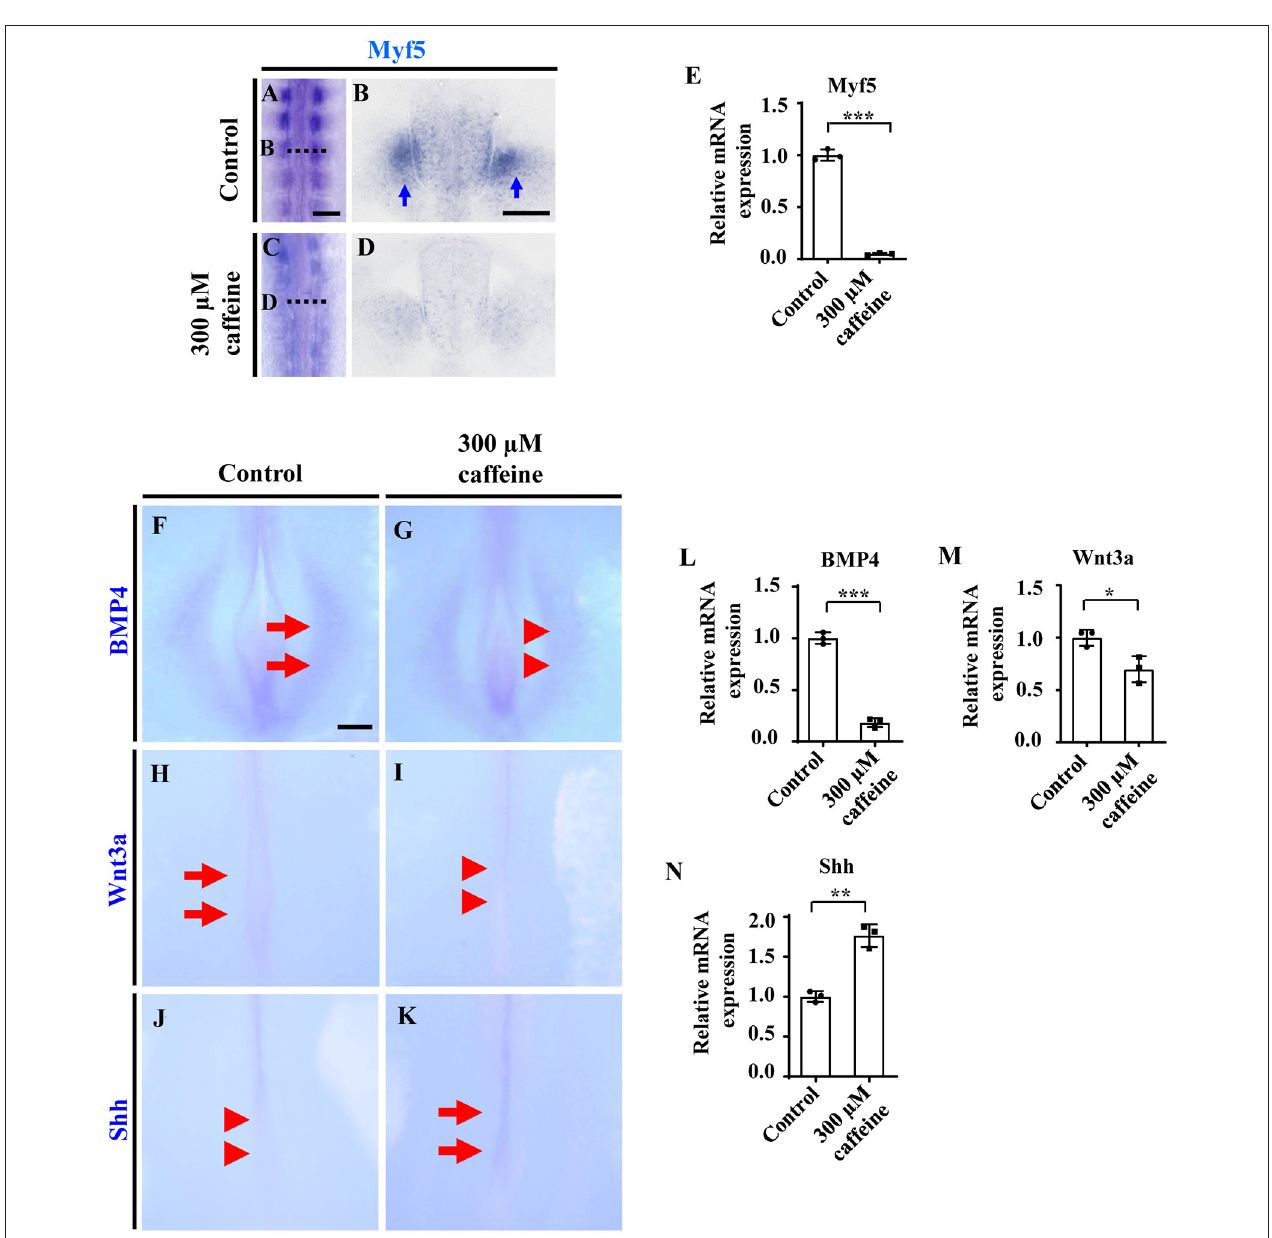
FIGURE 3 | Determination of cell differentiation in the developing somites following caffeine treatment. (A–D) Whole-mount in situ hybridization for Myf5 in the chicken embryos from control (A) and caffeine-treated (C) groups, and the corresponding transverse sections (B,D) . Panels (B/D) is from the fifth pair of somites. (E) Quantitative RT-PCR data showing the mRNA expression of Myf5 from the control and caffeine-treated groups. (F–K) Whole-mount in situ hybridization for BMP4, Wnt3a, and Shh in the chicken embryos from control (F,H,J) and caffeine-treated (G,I,K) groups. (L–N) Quantitative RT-PCR data showing the mRNA expression of BMP4, Wnt3a, and Shh from the control and caffeine-treated groups. Scale bars = 100 µ m in panels (A,C) ; 50 µ m in panels (B,D) ; 200 µ m in panels (F–K) . * P < 0.05, ** P < 0.01, *** P < 0.001.